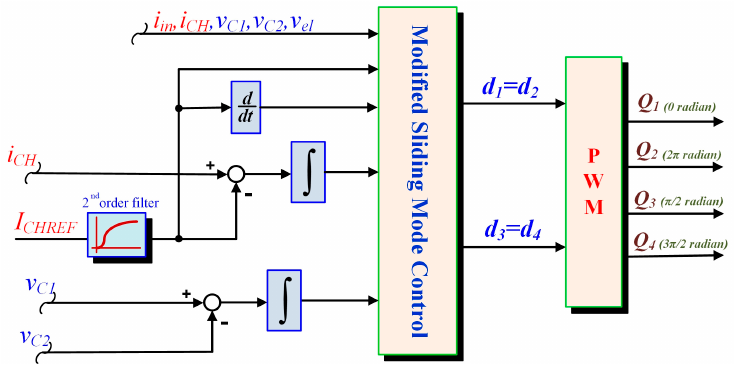
Figure 3. Schematic diagram of studied modified sliding mode control.